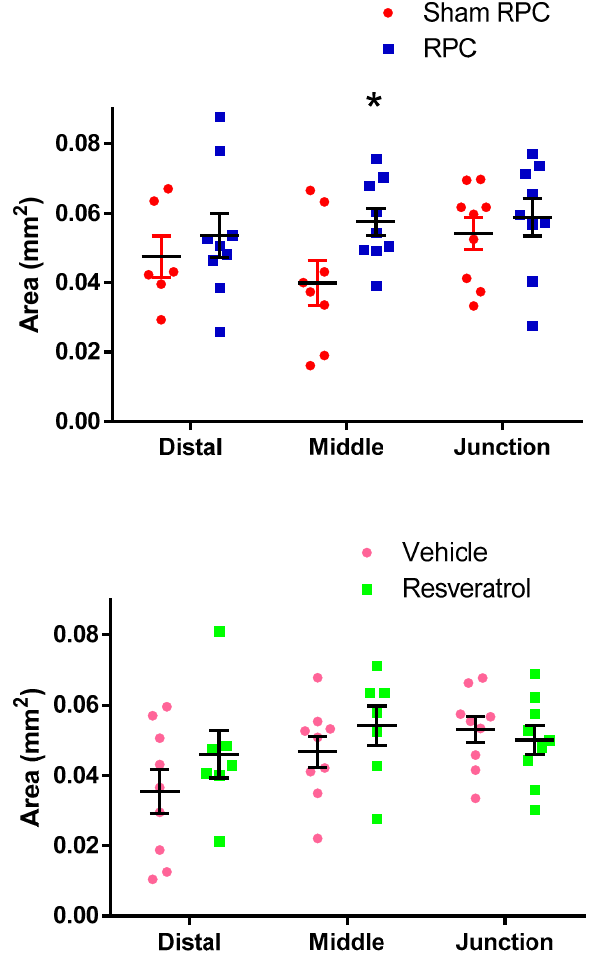
Figure 2. Mean cross sectional area of the basilar artery (* = p < 0.05).